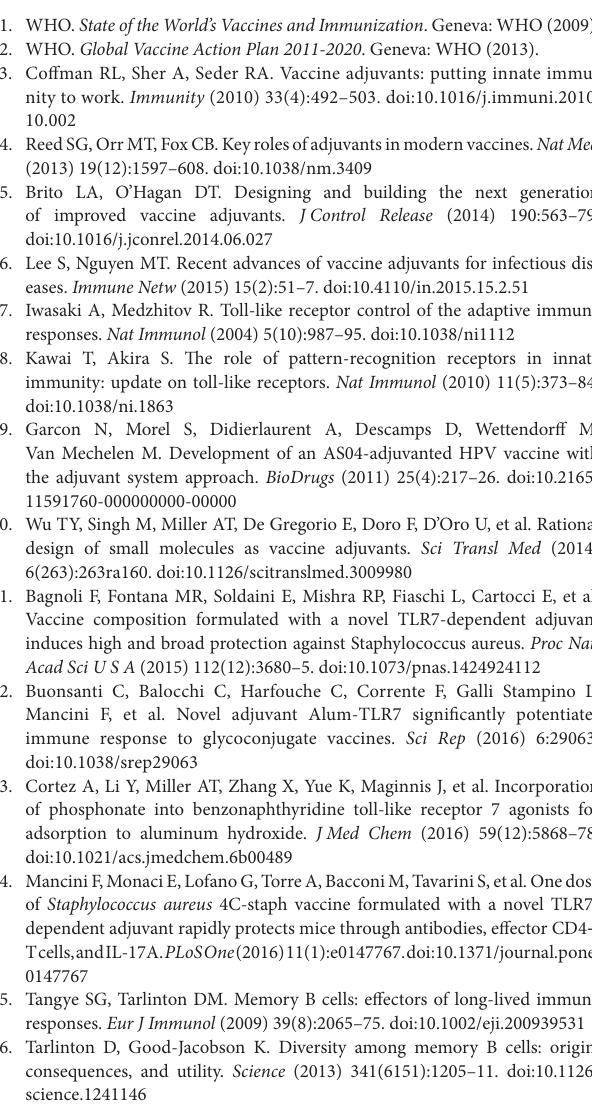
formulated with Alum or Alum/TLR7. Formulation buffer treated mice were used as negative control. After immunization, draining LNs, contralateral non- draining LNs, and spleens were collected, enzymatically digested, and analyzed by flow cytometry to identify antigen-specific B cells. Representative flow cytometry dot plots to show the gating strategy are reported. (a) Morphology to identify lymphocytes. (B) Live/dead staining to identify living lymphocytes. (c) Morphology to exclude doublets. (D) Antigen-specific B cells, identified as positive for CD45.1 (KL25 donor cells) and negative for CD45.2 (C57BL/6 recipient cells). (e) Identification of proliferated (CFSElow/negative) and non-proliferated (CFSEhigh) antigen-specific B cells by flow cytometry histogram. FigUre s3 | Popliteal draining lymph nodes (LNs) from mice immunized with Alum/TLR7 appear generally bigger than the others. Pictures of the popliteal draining LNs and popliteal contralateral non-draining LNs collected 3 days (a) , 1 week (B) , and 2 weeks (c) after the treatment, that compare their dimensions. Results of one experiment out of five independent experiments are